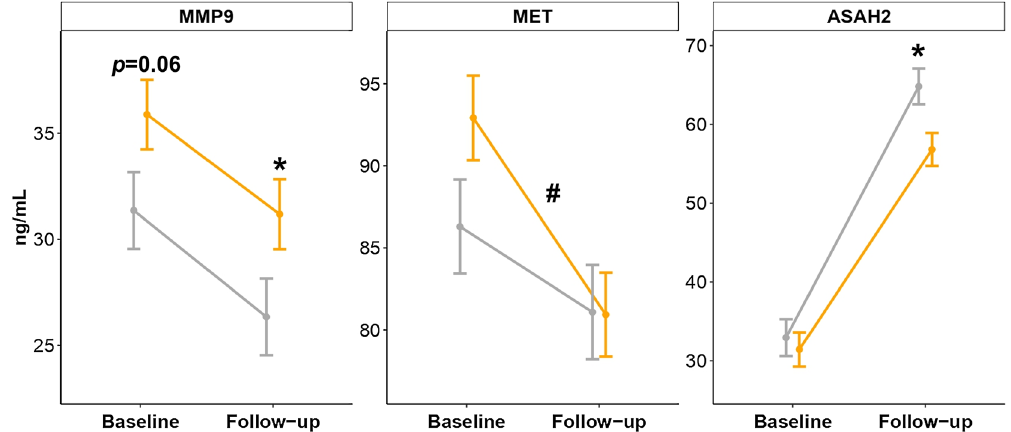
Figure 4. Biomarker concentrations in the replication phase (n = 160). Lines represent adjusted means from baseline to the follow-up visit in cases (black) and controls (grey). Error bars represent the standard error of the adjusted mean. These adjusted means have been extracted from mixed models and were corrected for baseline age, sex, visit, change in systolic blood pressure, and baseline WMH. *: p -value < 0.05 between groups at the baseline visit or at the follow-up visit. #: group and visit interaction p -value < 0.05. This interaction term represents the difference in the rate of changes between groups in biomarker concentrations.